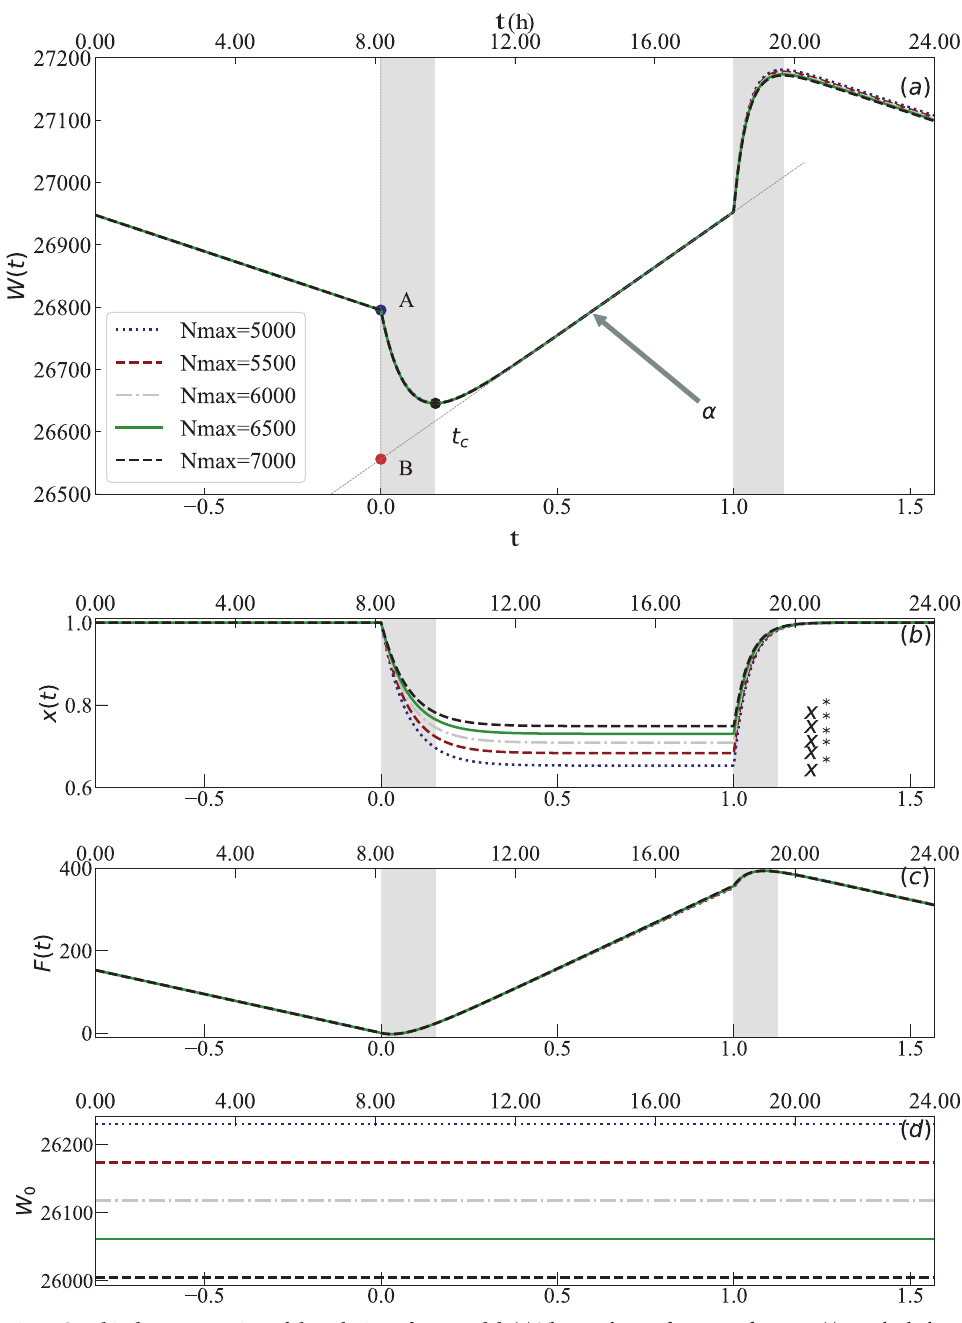
Fig 3. Graphical representation of the solution of our model. (a) The weight as a function of time, W ( t ), in which the three linear regimes and the two transition regimes (shaded areas) are visible. (b-d) The three key elements that compose W ( t ): (b) the number of foragers inside the hive x ( t ) that converges to the constant value x � ; (c) the amount of food F ( t ) inside the hive; and (d) the constant weight of the hive W 0 . In all four plots, five curves are shown for different model parameters θ = { N max , W 0 , a 1 , a 2 , d , m , ℓ = 18.74 g / h , w = 0.113 g / bee } that lead to the same effective parameters A , B , t c , α are W 0 [ g ] = 26230, 26173, shown in panel (a). The values of the remaining parameters in numerical order for N max 26117, 26060, 26004; a 1 [1/ h ] = 0.882, 0.914, 0.941, 0.964, 0.984; a 2 [1/ h ] = 2.329, 2.328, 2.328, 2.327, 2.327; d [1/ h ] = 0.469, 0.424, 0.387, 0.356, 0.330; and m [ g / bee ] = 0.038, 0.037, 0.036, 0.035, 0.034. The two grey spans highlight the time intervals of exponential decay and growth in x ( t ),